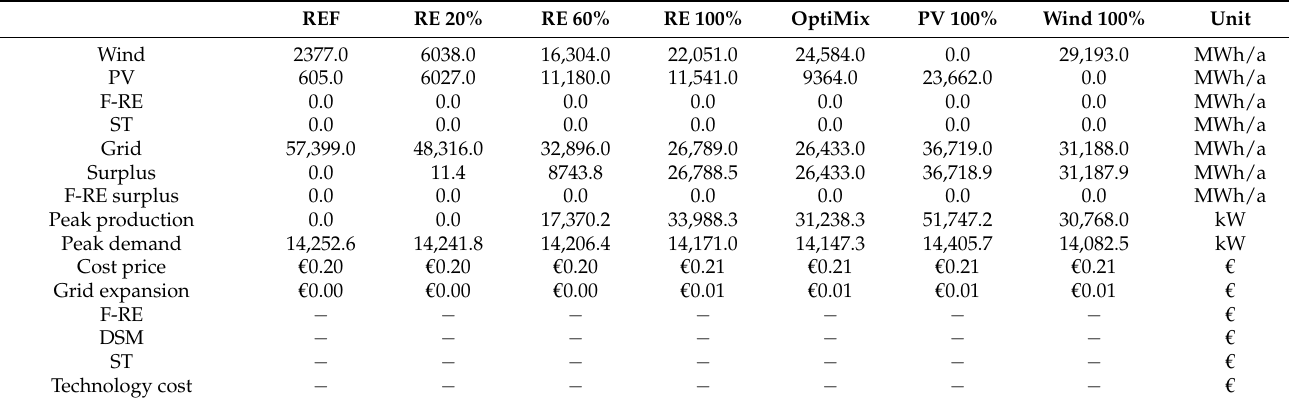
Table A10. Results from the renewable integration